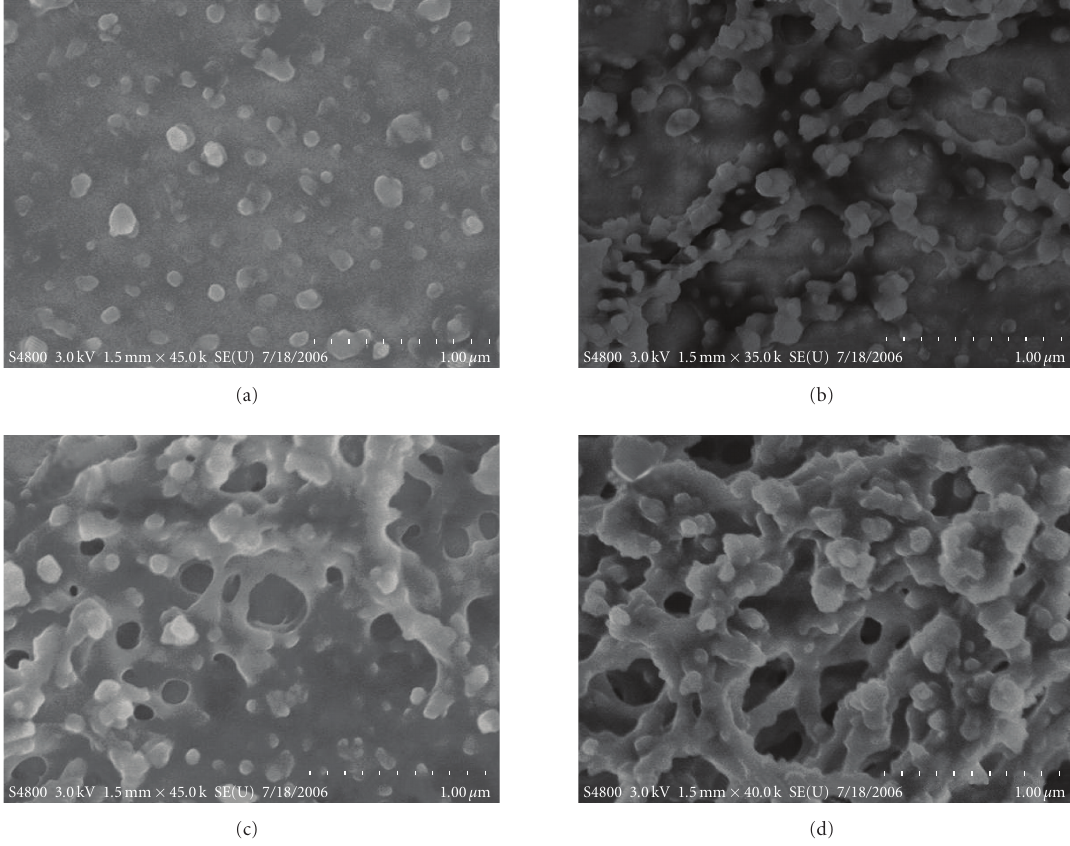
Figure 6: Scanning Electron Micrographs of (a) 2, (b) 6, (c) 12, and (d) 16 PDMS-1/PDMS-2 bilayered film prepared from water solutions.